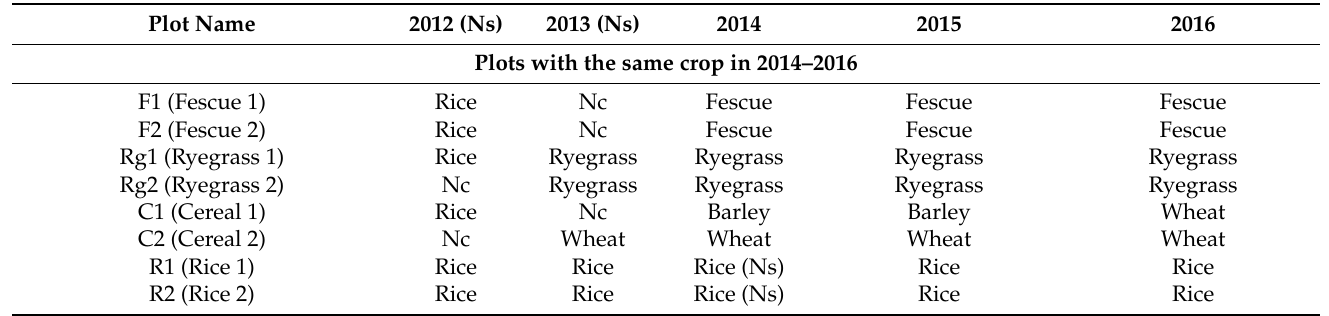
Table 1. Crops grown on the different surveyed plots between 2012 and 2016 in Aragon, Spain.